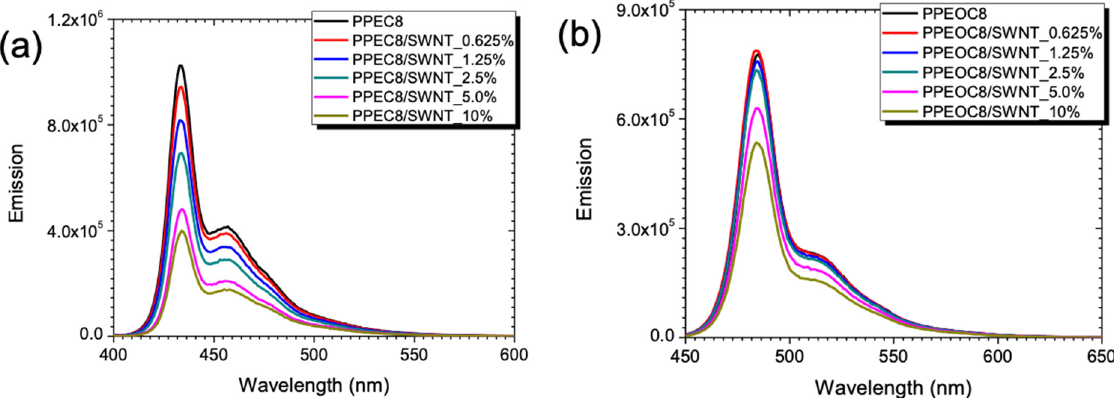
Figure 3. Fluorescence spectra (excitation at λ = 350 nm) of ( a ) PPEC8/SWNT and ( b ) PPEOC8/SWNT in DCB. The SWNT loading relative to PPE amount is 0 wt%, 0.625 wt%, 1.25 wt%, 2.5 wt%, 5 wt% and 10 wt%. The PPE concentration is set as 1 mg/30 mL.